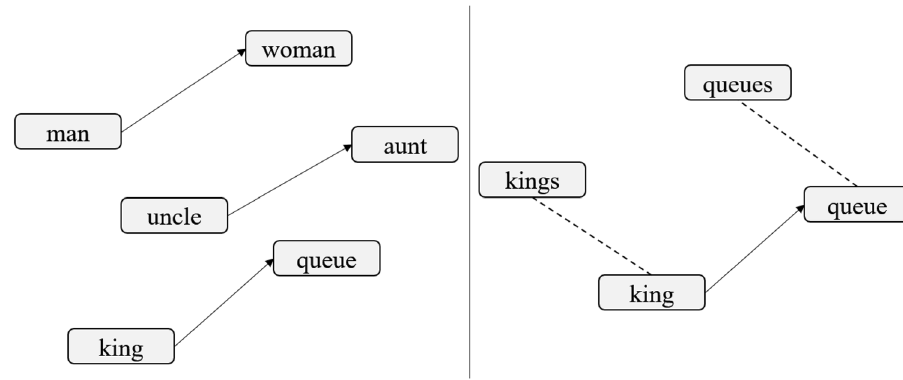
Fig. 11 Illustration of word analogy task